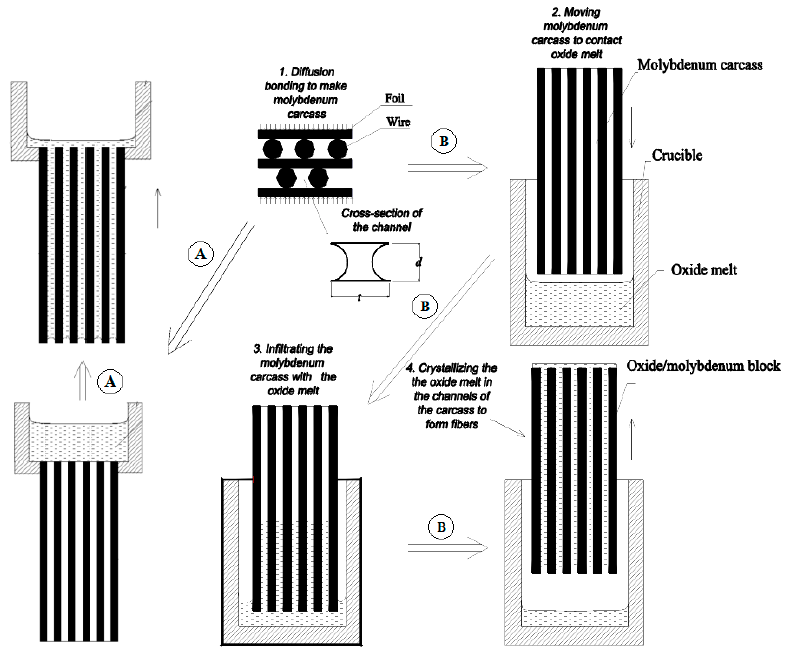
Figure 2. Two schemes of the schematic of the internal crystallization method to produce oxide fibers. The arrows marked by A and B illustrate the sequences of the steps corresponding to the first and second schemes, respectively.